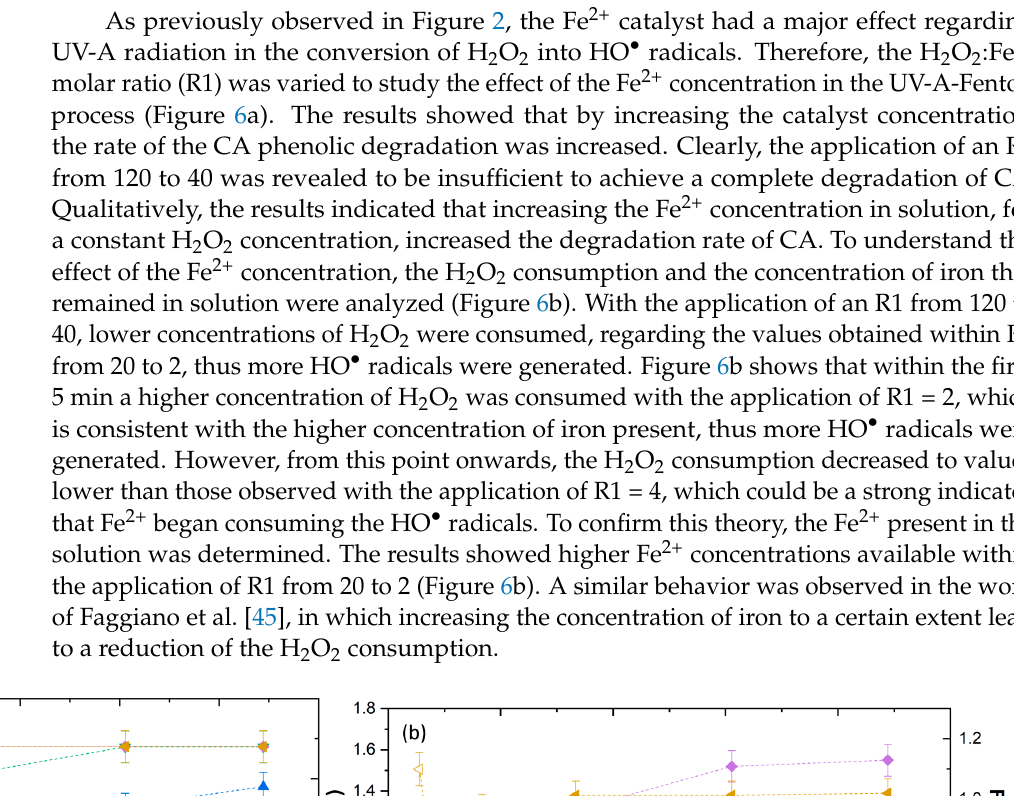
× 10 − 3 mol L − 1 , 2 O 2 ] = 2.2